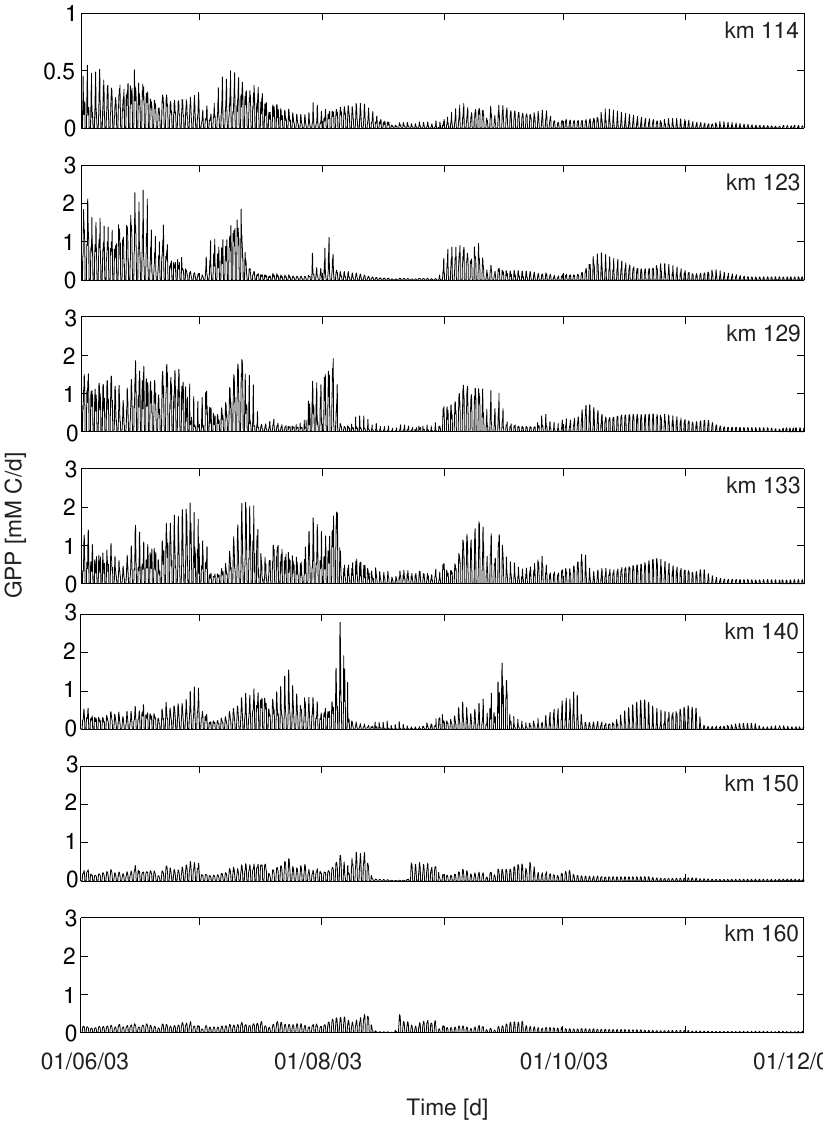
Fig. 6. Temporal evolution of gross primary production GPP at selected points in the tidal freshwater from June–December 2003.